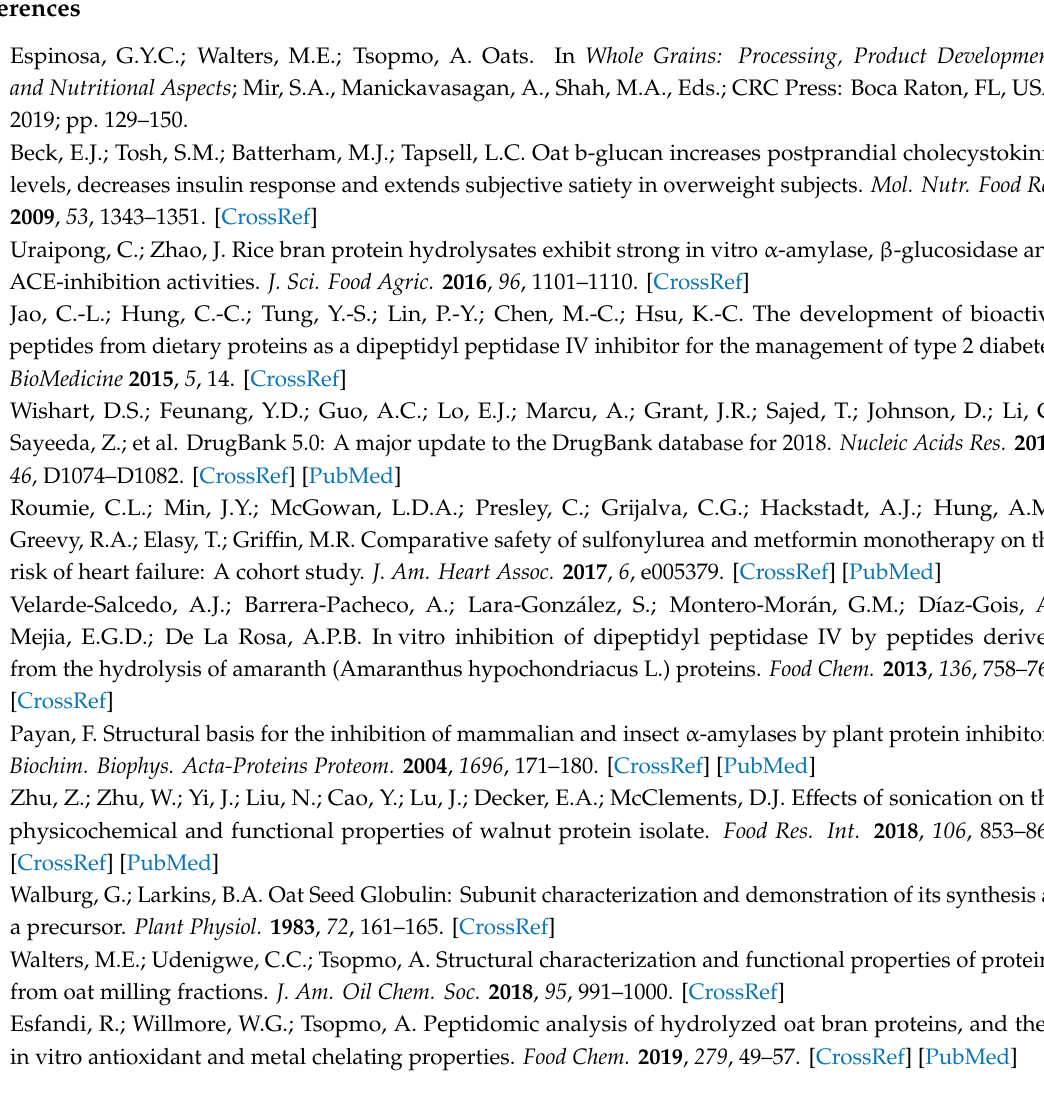
Figure S1: SDS-PAGE gel electrophoresis of isolated proteins in the absence and in the presence of a reducing agent. Samples (25 µ g) were run on a 12% resolving gel and 4% stacking gel for 1 hour at 120V and. Samples control (CTL) and brans pre-treated with ultrasonic bath (UB) or ultrasonic probe (UP) ultrasounds, Figure S2: (A) Soluble protein contents of hydrolysates in weight percentages; (B) Concentration of free amino acids (FAA, µ g / g hydrolysate); (C) Concentration of free sulfhydryl or thiol (SH) groups ( µ g / g protein). Data are means of triplicates ± standard deviation. Value with di ff erent letters are significantly di ff erent as determined by a one-way ANOVA coupled with a least significant di ff erence (LSD) test ( p -value < 0.05), Table S1: Composition of extracted proteins from oat brans. Each protein isolate was analyzed using LC-MS / MS after digestion by trypsin. Myoglobin was used as a control, and the sequences were analyzed using Mascot TM Software. (-) indicates an absence of protein. Proteins are from control (CTL) and brans pre-treated with ultrasonic bath (UB) or ultrasonic probe (UP)